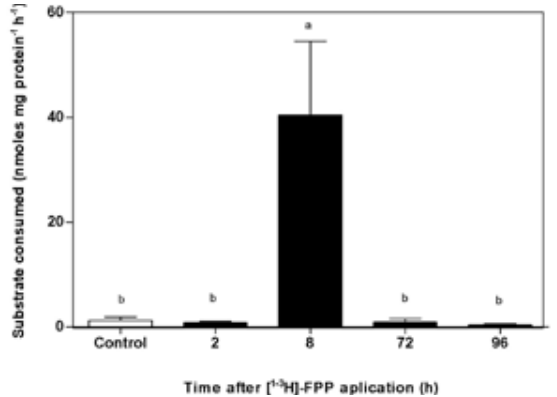
Figure 1. TPS activity expressed as nmoles of [ 1-3 H]-FPP consumed per mg protein -1 h -1 in calluses inoculated with 2 μL 10 7 (C1), 10 8 (C2) and 10 9 (C3) or 10 μL 10 9 (C4) conidia mL -1 and in control.